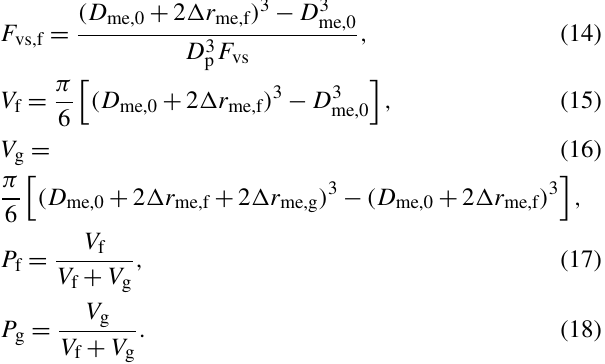
( N) . We assume that the primary particles of soot aggregates are in point contact and the material density of these particles is the same as that (1.77 g cm − 3 ) of the